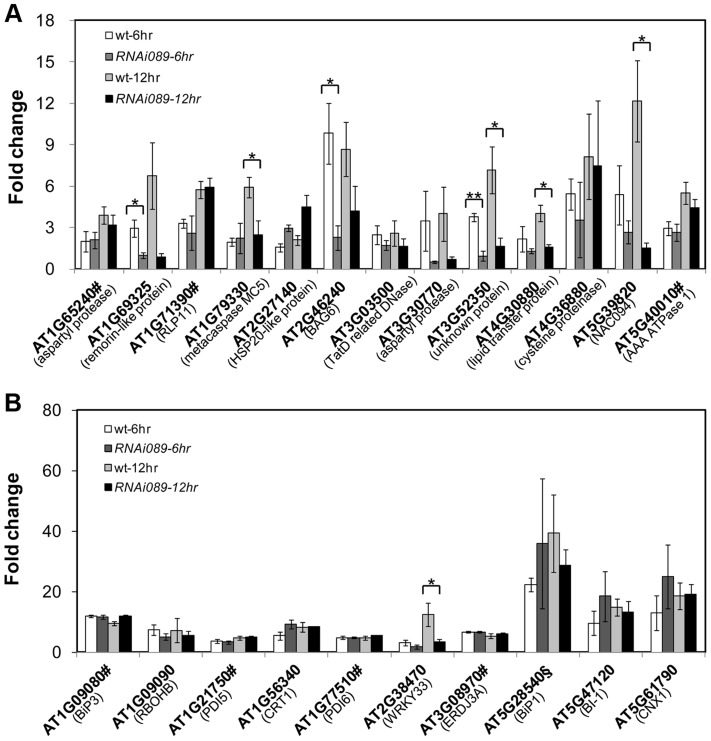
Up-regulation of NAC089D-MYC-regulated genes by ER stress is impaired in the NAC089 RNAi plants.The expressions of NAC089D-MYC downstream genes (A) and other UPR markers (B) were quantified with qRT-PCR in the wild-type control (wt) and NAC089 knock-down plants (line RNAi089-25). Fold change is the gene expression value in TM (5 µg/ml) -treated plants divided by the value in non-treated plants, both of which were normalized to the expression of actin. Bars depict SE (n = 3). Values for the gene locus with # are log2 values. Fold change of BiP1 (AT5g28540, highlighted with §) also includes that of BiP2 (AT5G42020). ** P<0.01, * P<0.05.